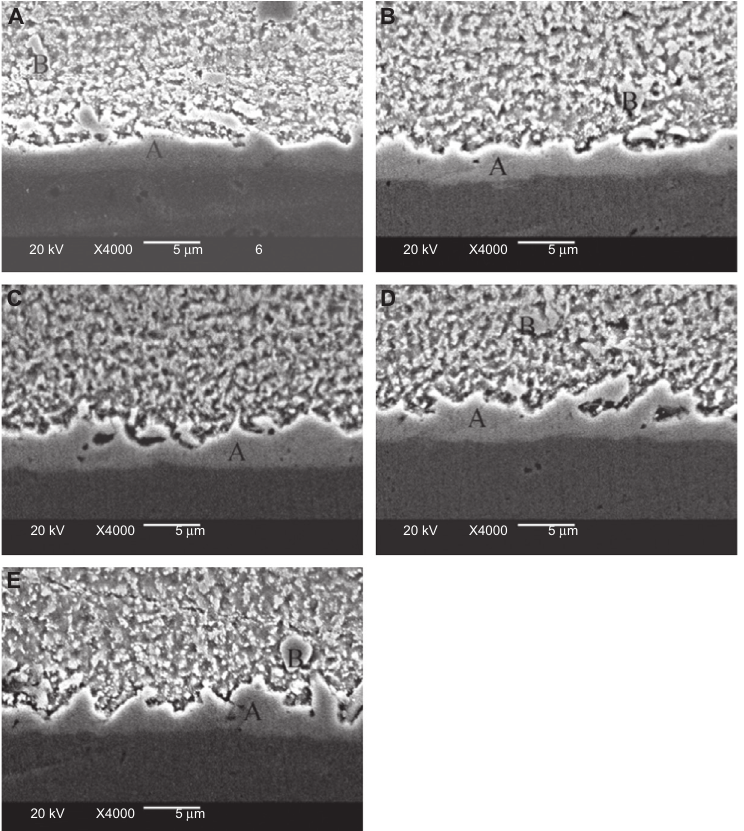
Figure 4 SEM micrographs of as-solidified solder joints made from (A) SAC305, (B) SAC305 – 0.05 vol% MWCNT, (C) SAC305 – 0.1 vol% MWCNT, (D) SAC305 SAC305 – 0.5 vol% CNT, and (E) SAC305 SAC305 – 1.0 vol%